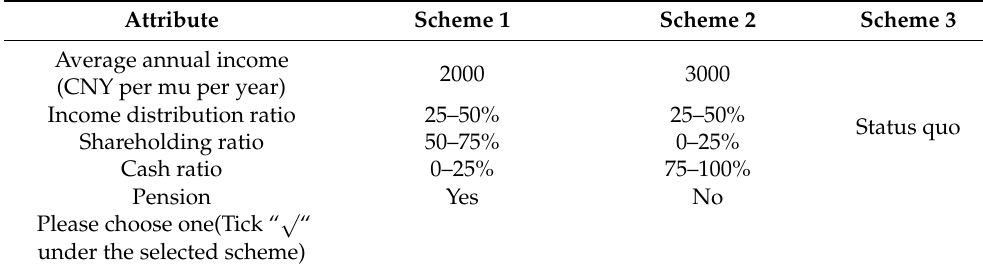
Table 3. An example of a choice occasion for the